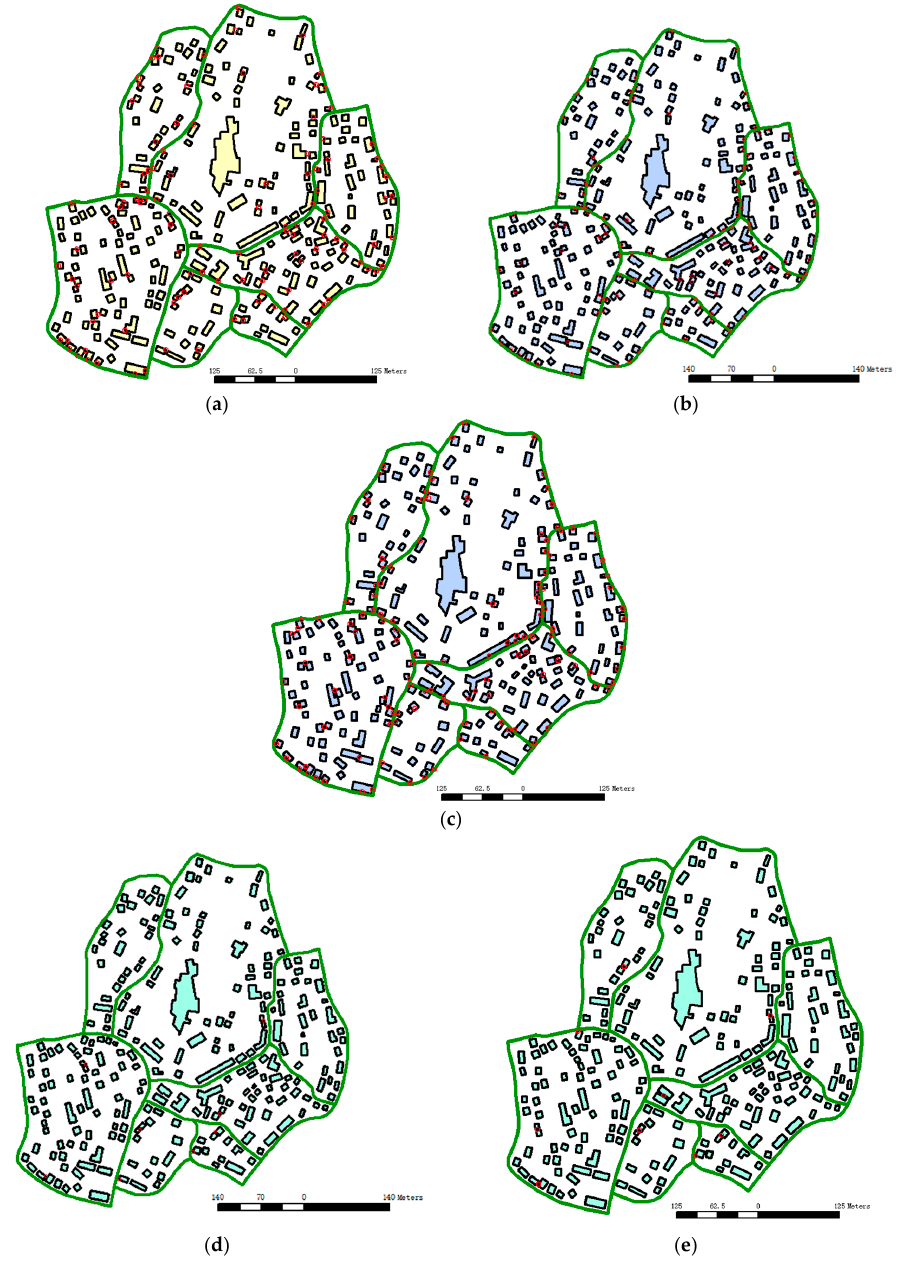
Figure 8. Building conflicts and displacements: ( a ) The original map with graphic conflicts; ( b ) the displacement result of the immune genetic algorithm IGA after 10 iterations; ( c ) the displacement result of IGA after 20 iterations; ( d ) the displacement result of the improved PSO after 10 iterations; ( e ) the displacement result of the improved PSO after 20 iterations. (The scale of all five maps is 1:25,000). We find that secondary conflicts occur in the IGA displacement result. Some concave polygons overlap with other polygons, and some polygons overlap at road corners. We suspect that the mutation operator applied to the movement vector in the IGA may cause buildings to overlap that